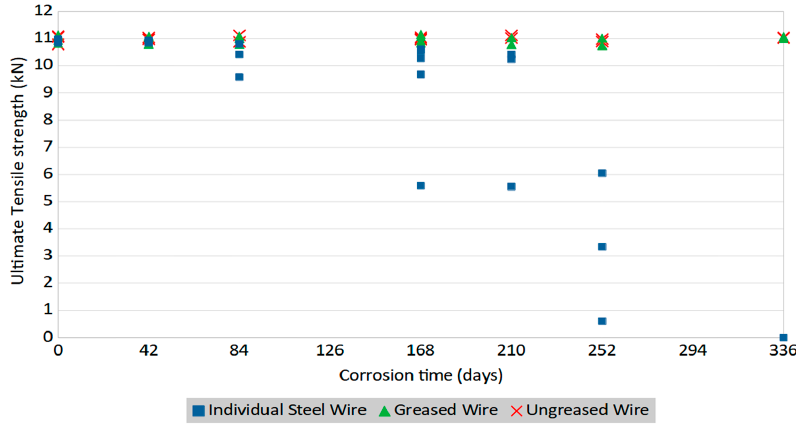
Figure 14. Ultimate tensile strength of corroded steel wires for different exposure